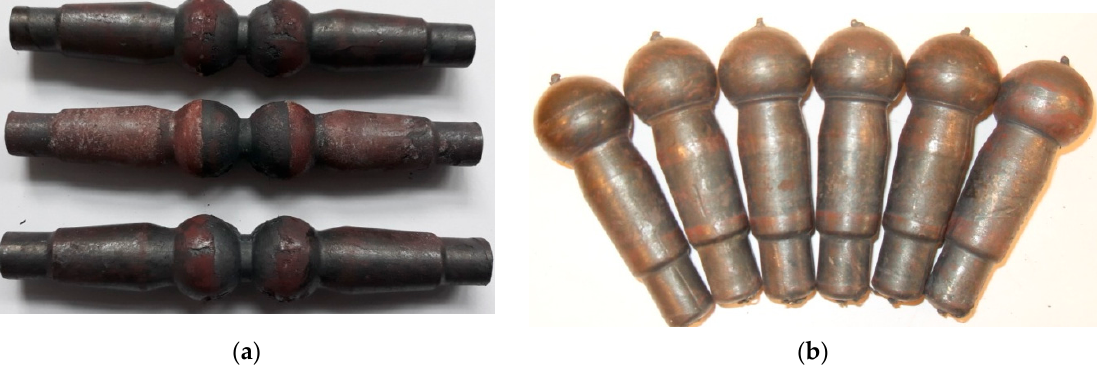
Figure 4. Ball studs obtained by: ( a ) cross-wedge rolling (CWR); ( b ) helical-wedge rolling (HWR).